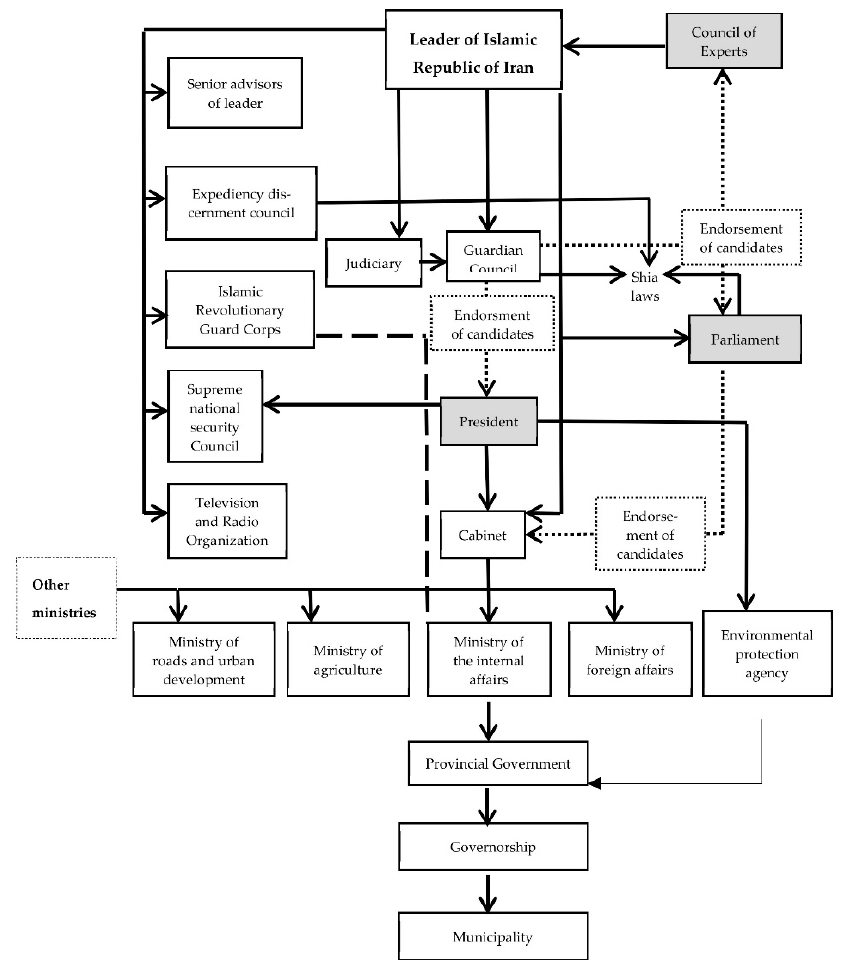
Figure 2. Governmental structure of the Islamic Republic of Iran.